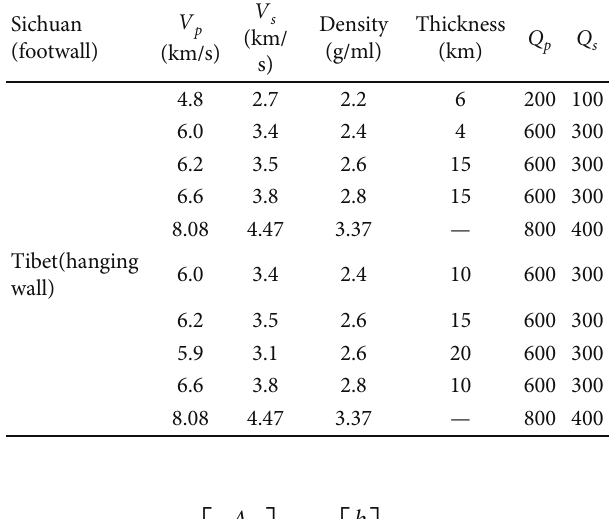
Figure 2: The position of 120 horizontal GPS observation stations; red and black squares indicate the footwall and hanging wall stations, respectively. The rectangle box is the projection of the fault, and the pentagram is the epicenter. The blue circles indicate towns. Table 1: The structural